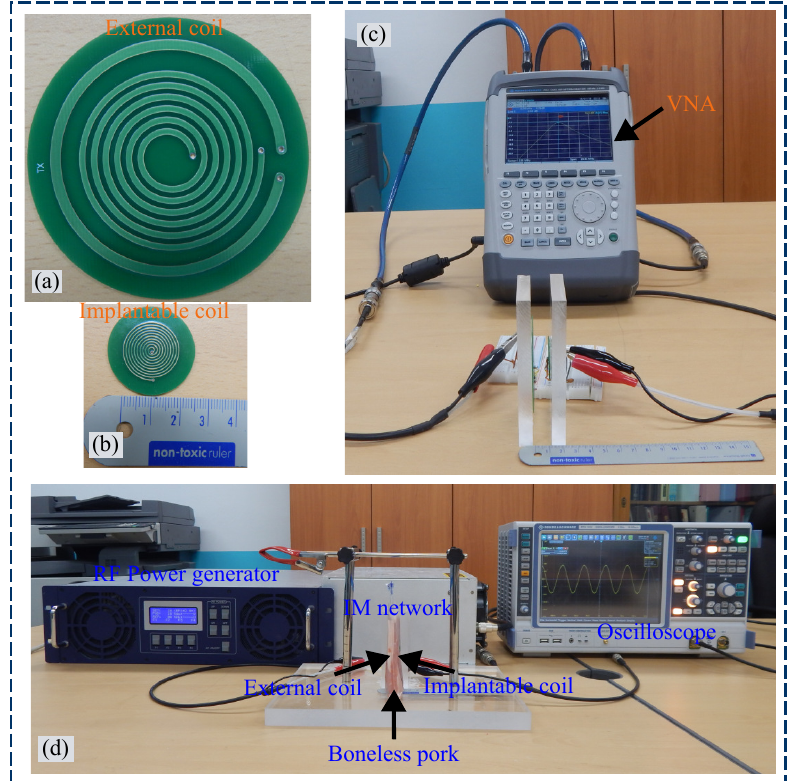
Figure 8. Fabrication of ( a ) External coil; ( b ) Implantable coil; ( c ) Experimental setup for measuring the PTE; ( d ) Experimental setup for measuring the